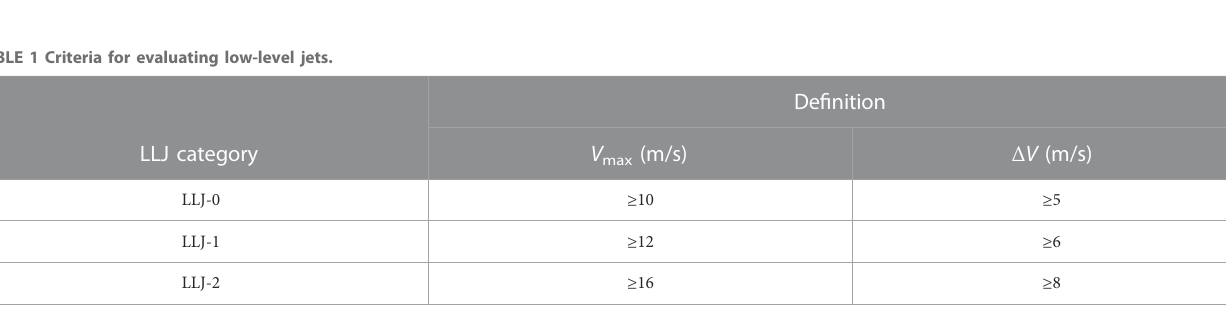
TABLE 1 Criteria for evaluating low-level